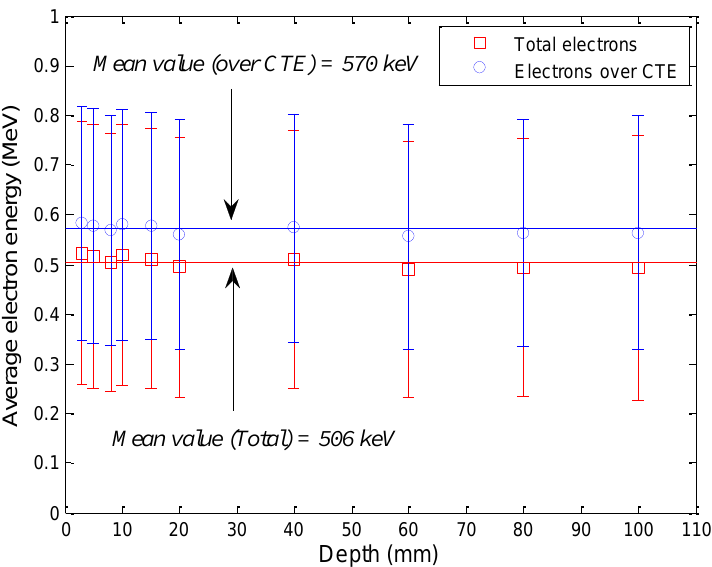
Figure 5. Average energies of electrons generated in polystyrene according to depths of a water phantom.